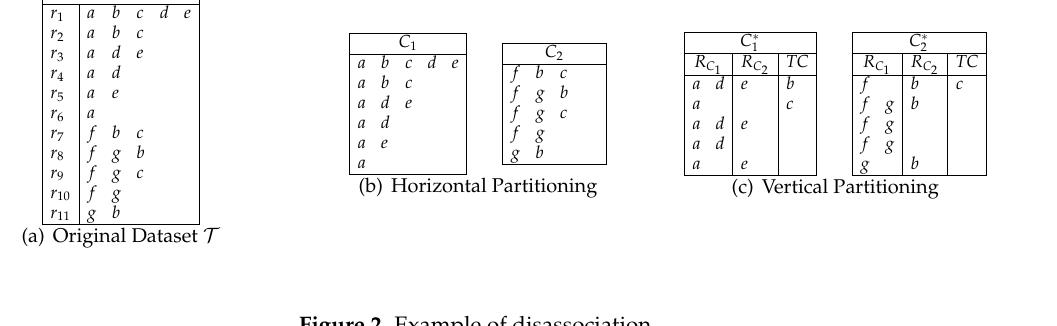
Figure 2. Example of